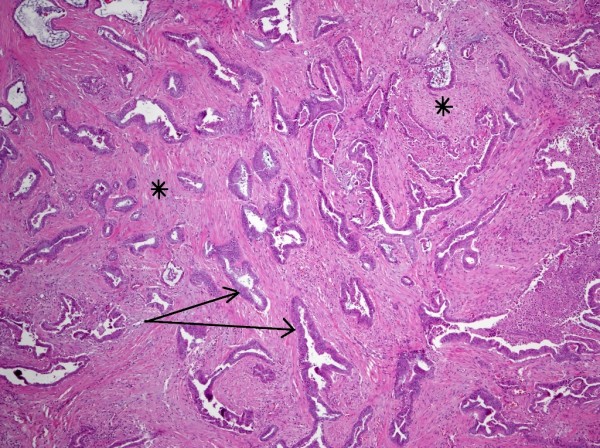
Low magnification of pancreatic mass showing an infiltrative tumor composed of angulated glands (see arrow) distributed irregularly in a desmoplastic stroma (asterisk).